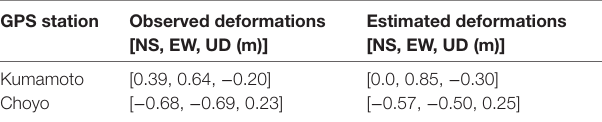
TaBle 1 | comparison of the observed and estimated ground deformations at the Kumamoto and choyo gPs stations for the